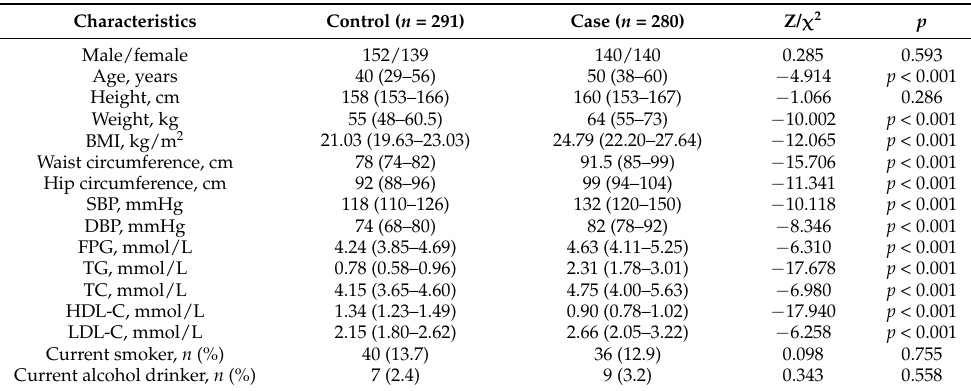
Table 2. Demographic and clinical characteristics of study